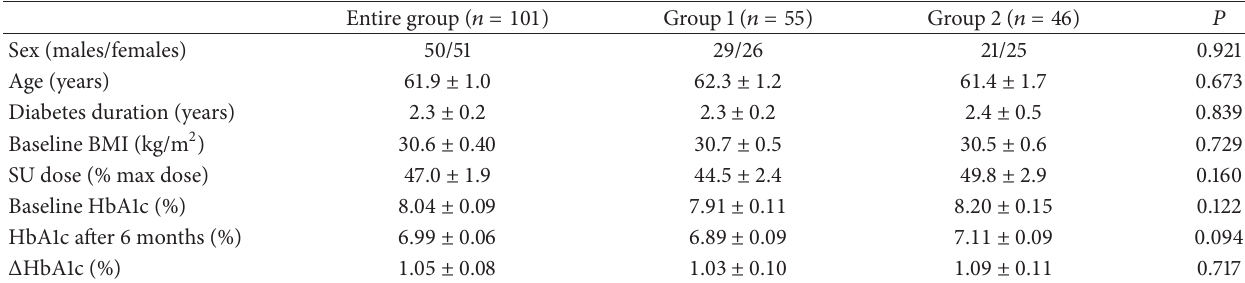
Table 1: Clinical and biochemical characteristics of the patients according to treatment with gliclazide (Group 1) or K binding sulfonylureas (Group